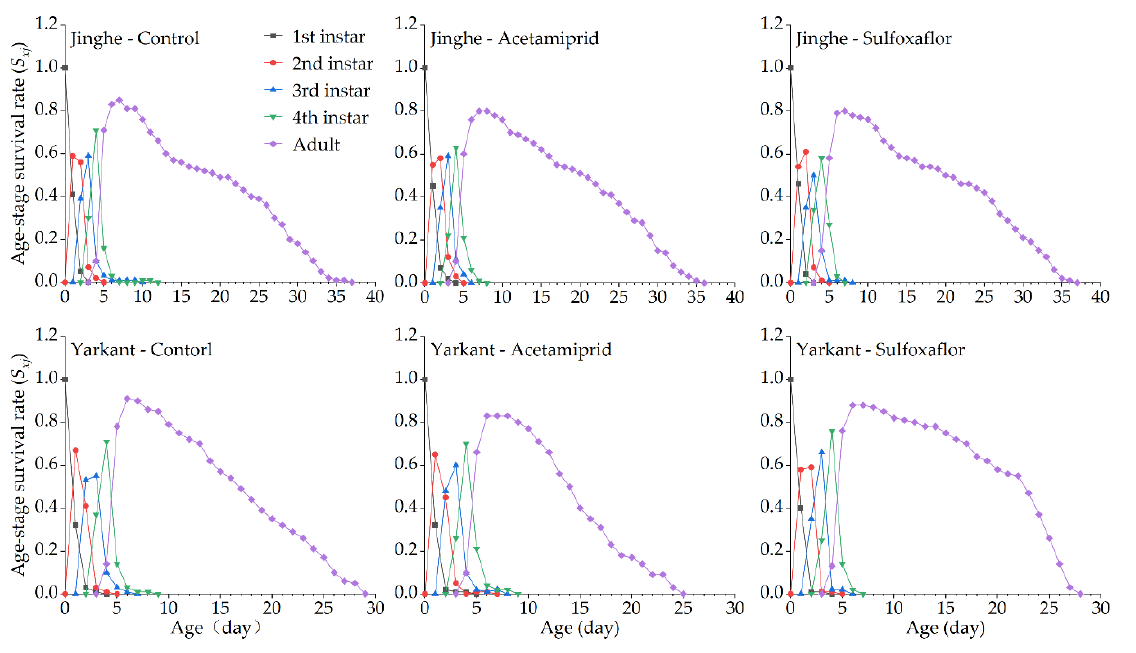
Figure 2. Effects of sublethal concentrations (LC 25 ) of acetamiprid and sulfoxaflor on the age-stage specific survival rate ( S xj ) of A. gossypii of the F 1 generation in Yarkant and Jinghe.